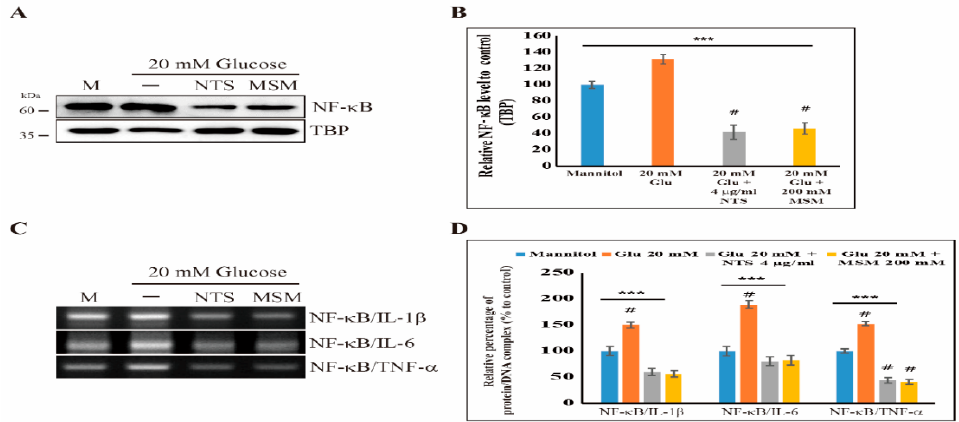
Figure 5. Sulfur compounds inhibit the nuclear translocation of NF- κ B and its binding to proinflammatory cytokines. ( A ) Western blotting analysis of nuclear extracts harvested from THP-1 cells treated with 4 μ g/mL NTS or 200 mM MSM for 72 h showing the inhibition of the high glucose-induced nuclear translocation of NF- κ B. TBP (TATA-binding protein) was detected for nuclear loading control. ( B ) The representative expression levels of proteins after NTS treatment were determined by densitometry and normalized to TBP. The values are presented as means ± SEM of three independent experiments performed in duplicate ( n = 3). *** p < 0.001 (ANOVA test). #The mean difference is significant at the 0.001 level. ( C ) ChIP assay analysis showing an inhibition of the binding of NF- κ B protein to the DNA of IL-1 β , IL-6, and TNF- α by treatment with 4 μ g/mL NTS or 200 mM MSM for 72 h. ( D ) The representative expression levels of complexes following NTS and MSM treatment were determined by densitometry, and controls were set to 100%. The values are presented as means ± SEM of three independent experiments performed in duplicate ( n = 3). *** p < 0.001 ( ANOVA test). #The mean difference is significant at the 0.001 level.